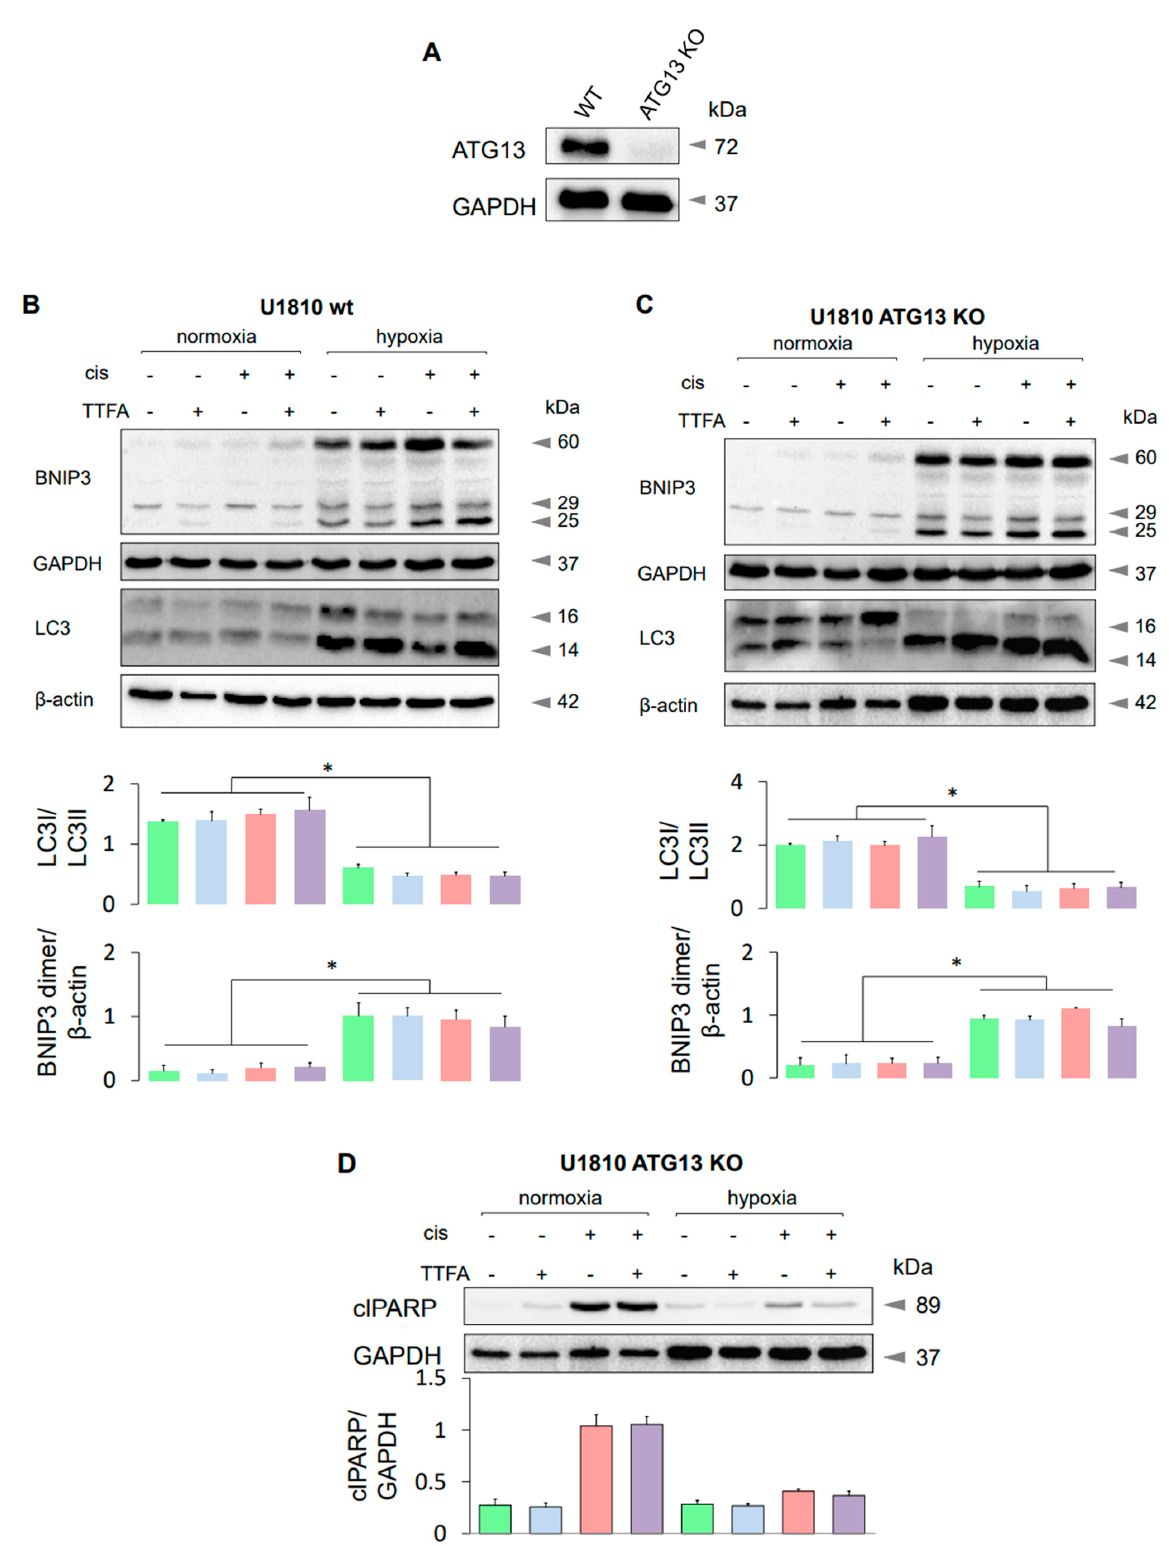
Figure 4. The consequences of hypoxia in wild-type (WT) and ATG13 knockout (KO) U1810 cells. The ATP13 content in WT and KO U1810 cells ( A ), hypoxia-triggered accumulation of BNIP3 and LC3 in WT ( B ) and ATG13 KO U1810 cells ( C ), hypoxia-induced suppression of apoptosis in ATP13 KO U1810 cells ( D ). GAPDH and β -actin were used as loading controls. Bars under blots show quantification of Western blot data based on three independent experiments; * p < 0.01.